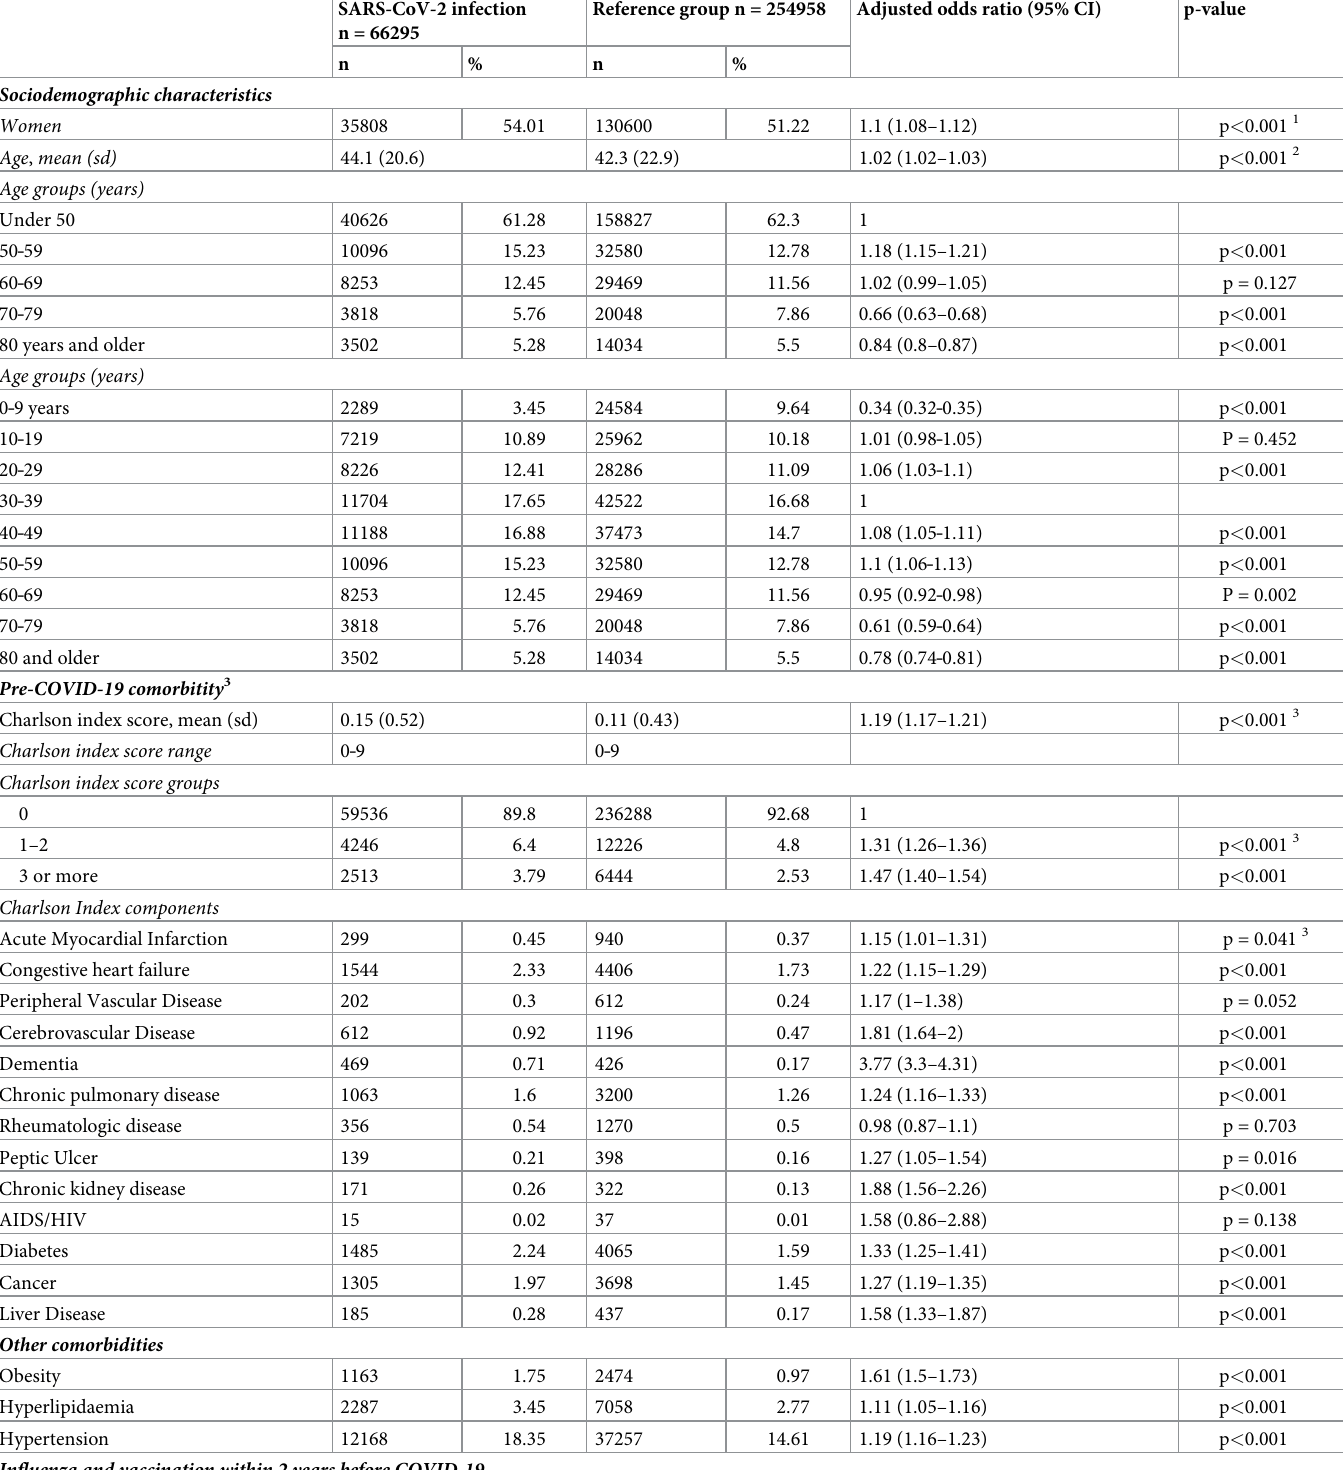
Table 1. Characteristics of patients with COVID-19 and controls in Estonia for the period of 26 February 2020 to 28 February